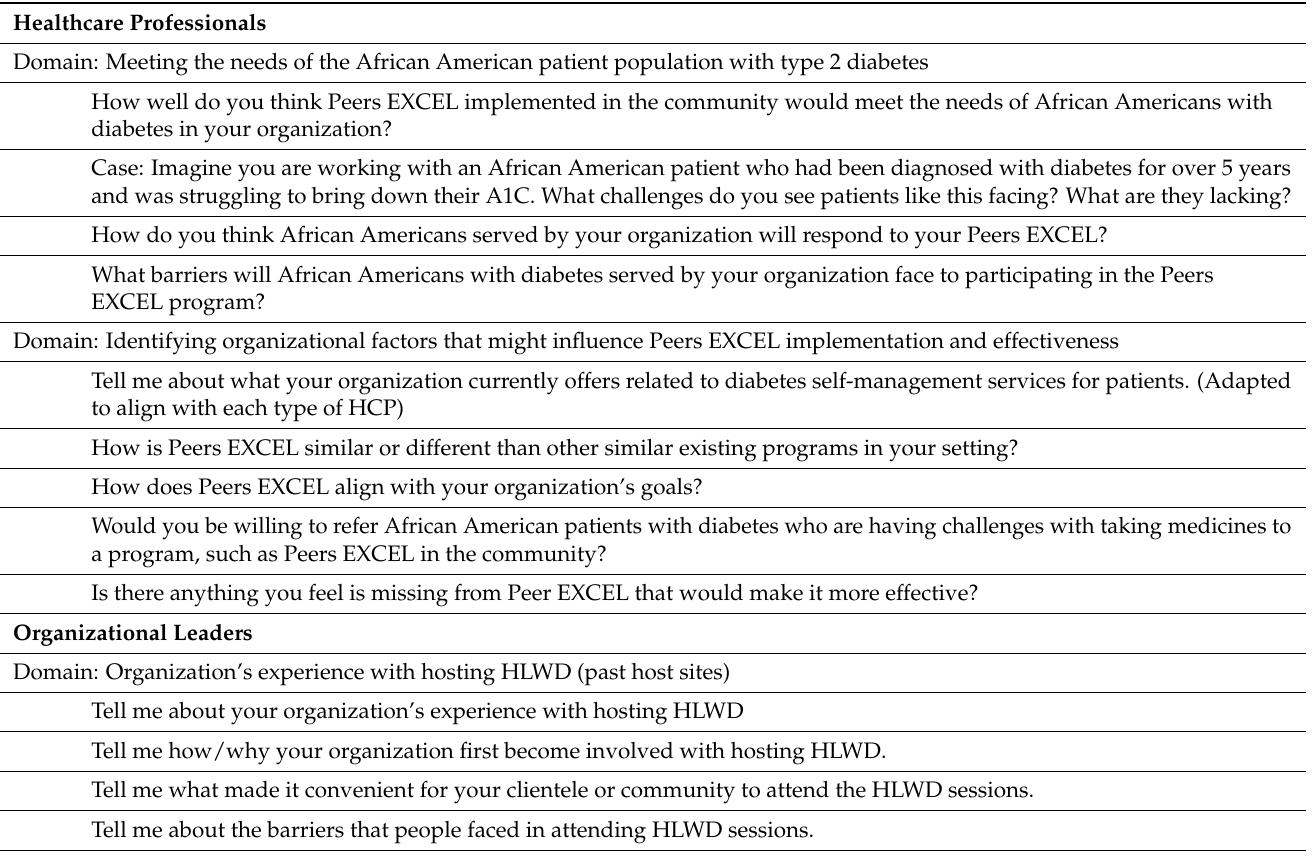
Table 1. Interview Questions for Healthcare Professionals and Organizational